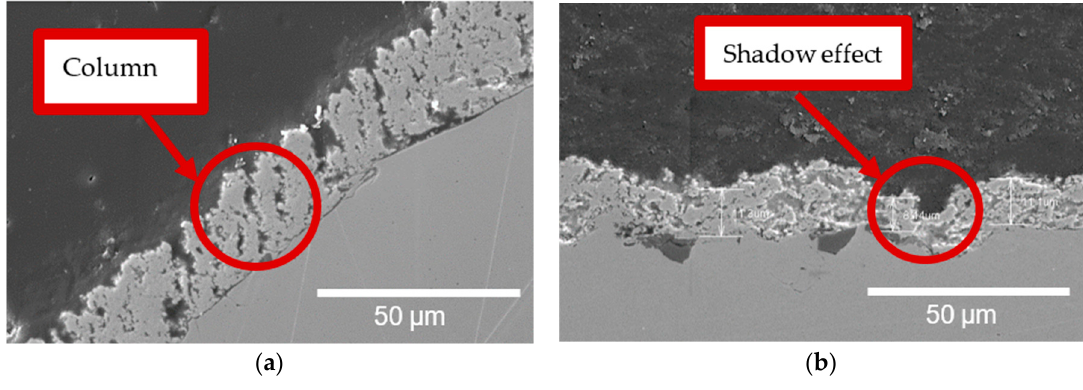
Figure 9. Coatings features: ( a ) columns; ( b ) shadow effect.